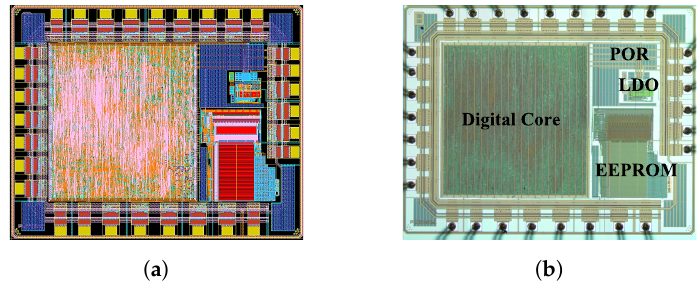
Figure 8. ( a ) Layout; ( b ) die micrograph. The die size is 3.2 mm × 2.7 mm.